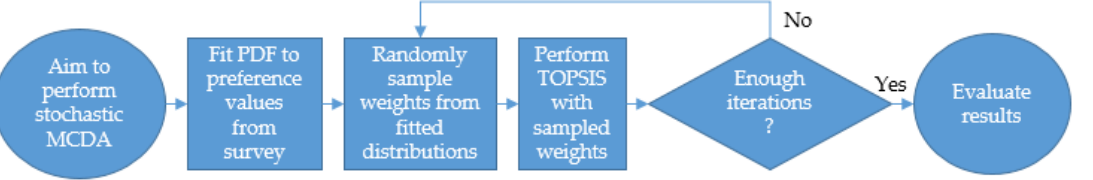
Figure 10. Process to stochastically expand MCDA.